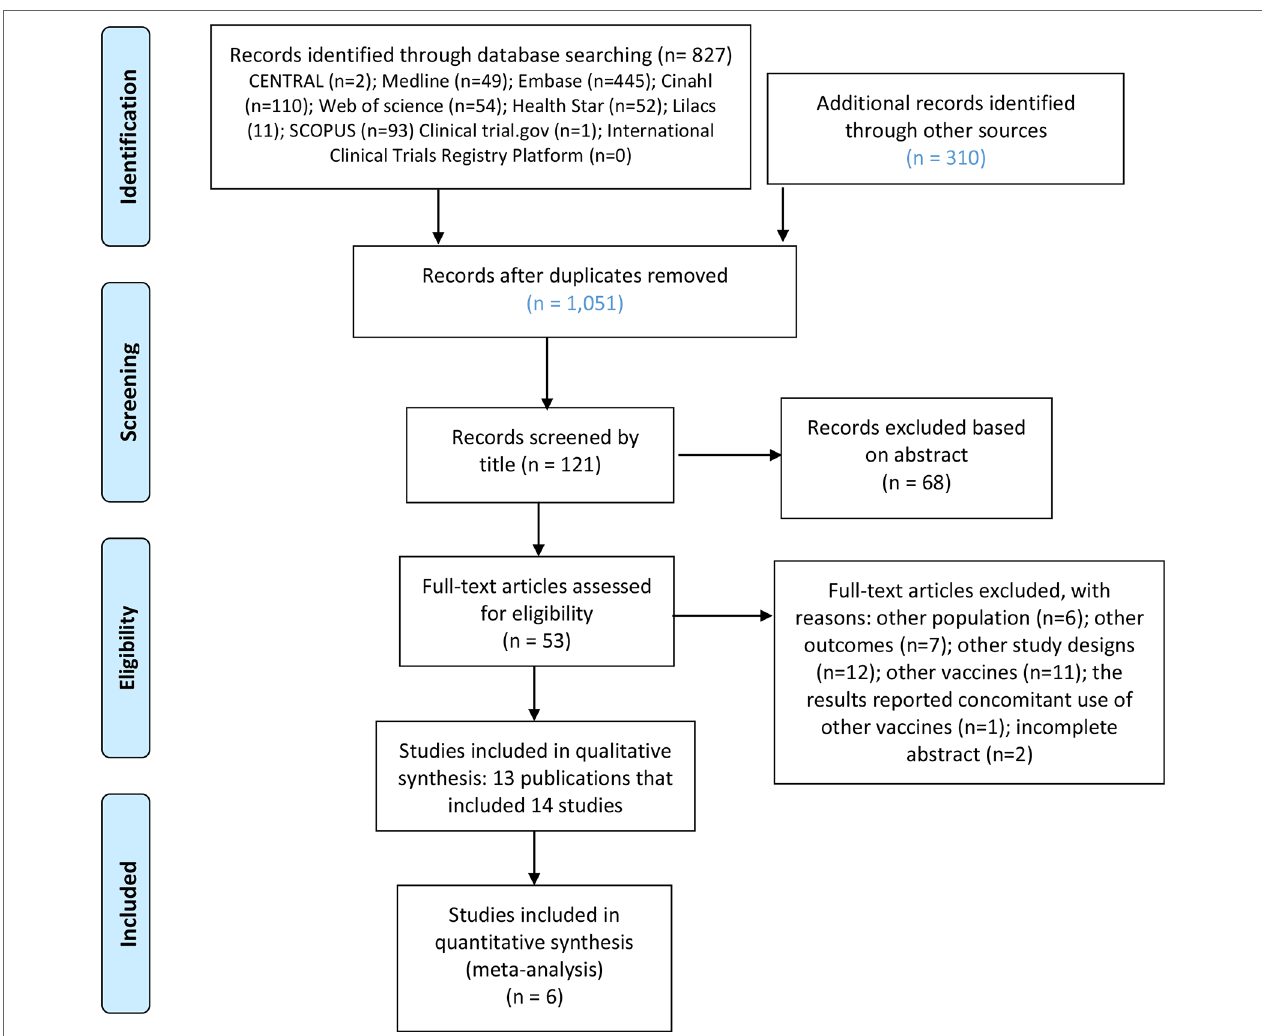
FIGURE 1 | Study selection